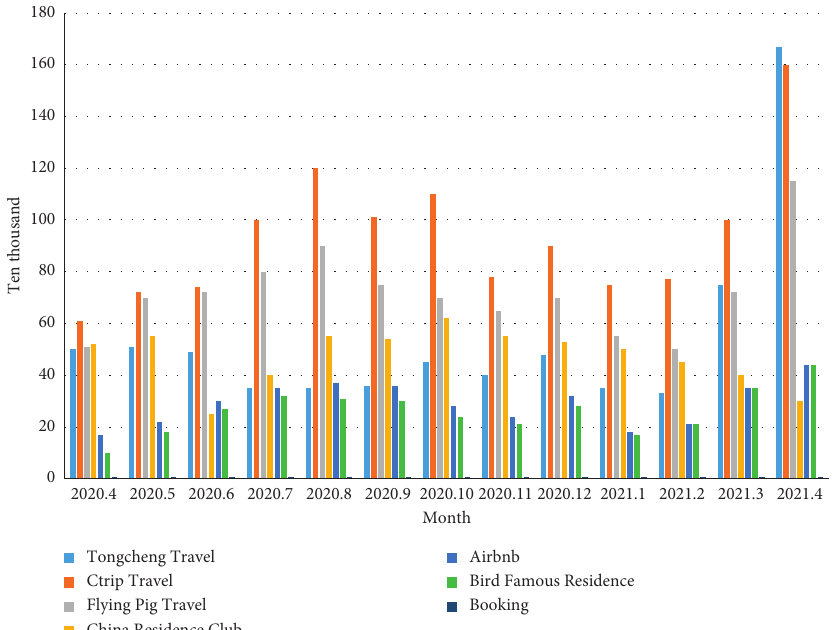
Figure 9: Travel platform access information for hotel